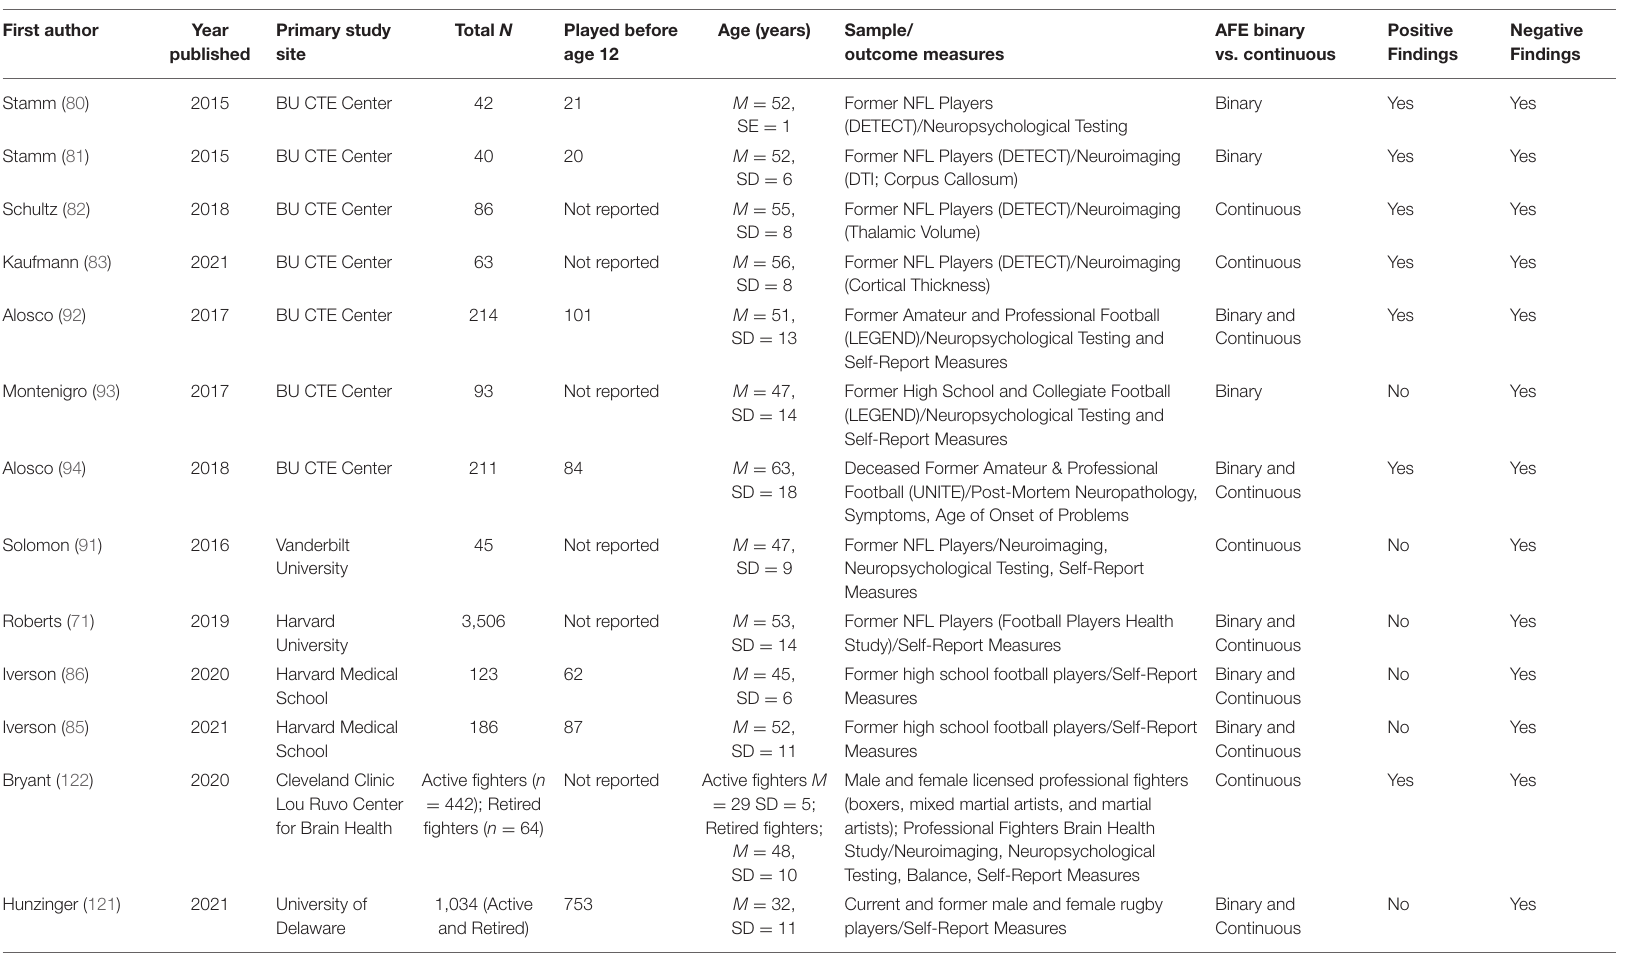
TABLE 1 | Summary of studies of retired